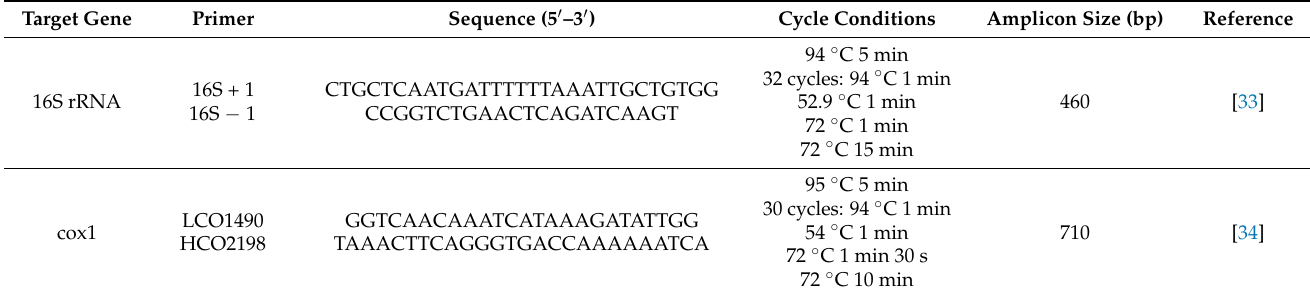
Table 1. Primers and thermo-cycle conditions used to amplify gene fragments. Target Gene